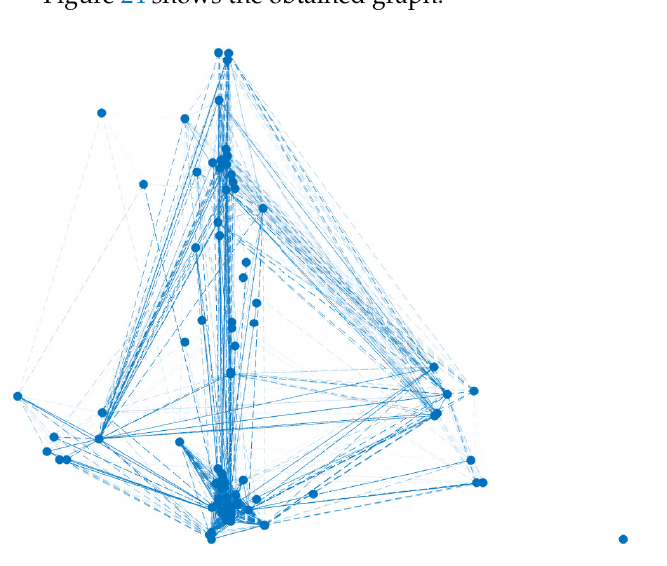
Figure 24. Graph obtained from database of Olmué city, Chili, with 3866 vertices and 6,841,470